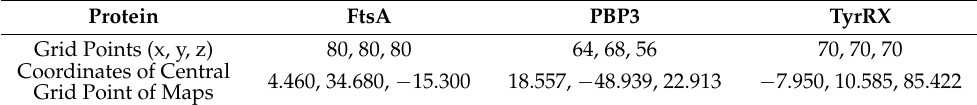
Table 8. Molecular docking grid box parameters for FtsA, PBP3 and TyrRX proteins. Protein FtsA PBP3 TyrRX Grid Points (x, y, z) 80, 80, 80 64, 68, 56 Grid Point of